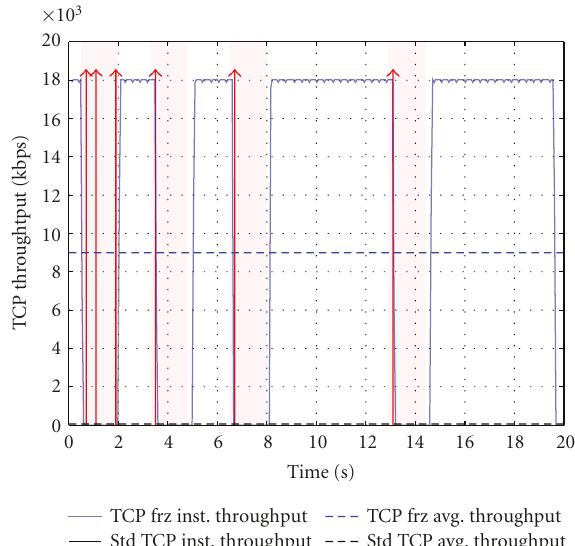
Figure 6: E ff ect of the smart lion attack on TCP throughput freezing and nonfreezing TCP transmission.